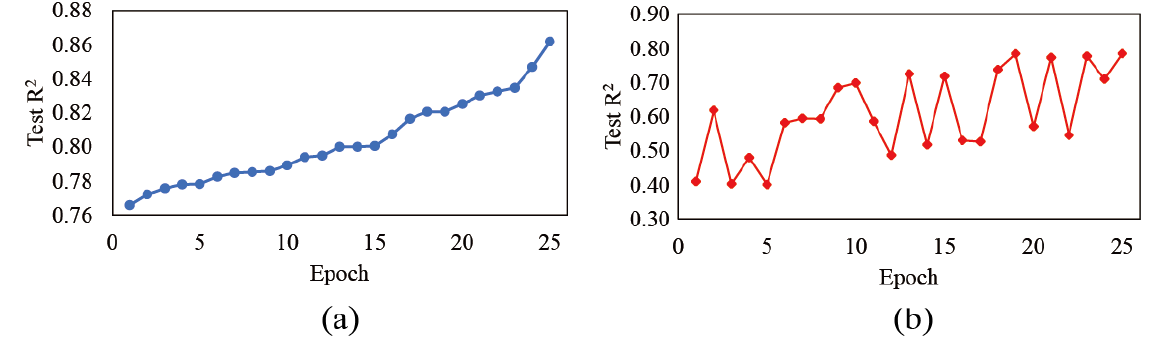
Figure 9. Accuracy comparison with the test dataset. ( a , b ) depict the test R 2 of the double-attention RNN and comparative model. Separately, the blue dotted line shows the test R 2 of the double-attention RNN; the rhombic line shows the test R 2 of the ablation model.